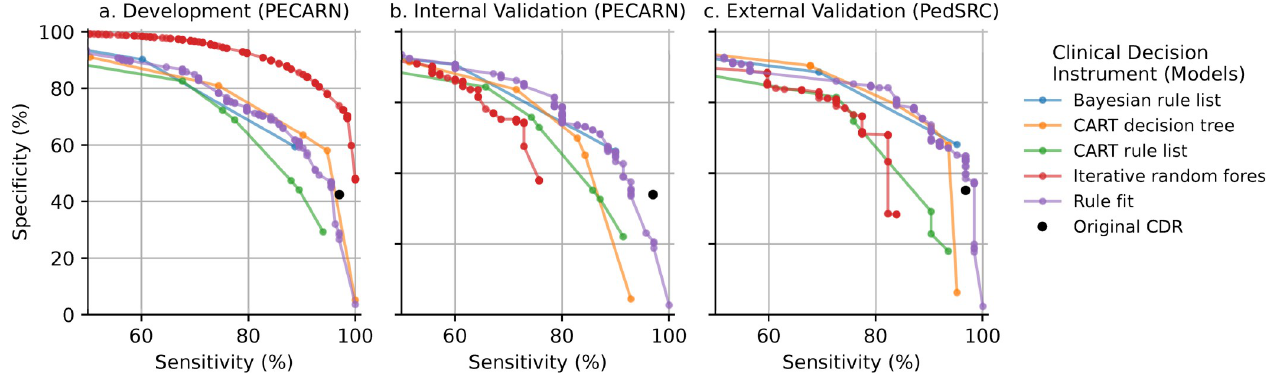
Fig 1. Sensitivity-specificity curves for clinical decision instruments to evaluate children after blunt torso trauma on the PECARN (a) development dataset (b) internal validation dataset, and (c) external validation on the PedSRC. The clinical decision instruments were then ranked by predictability from best to worst (top to